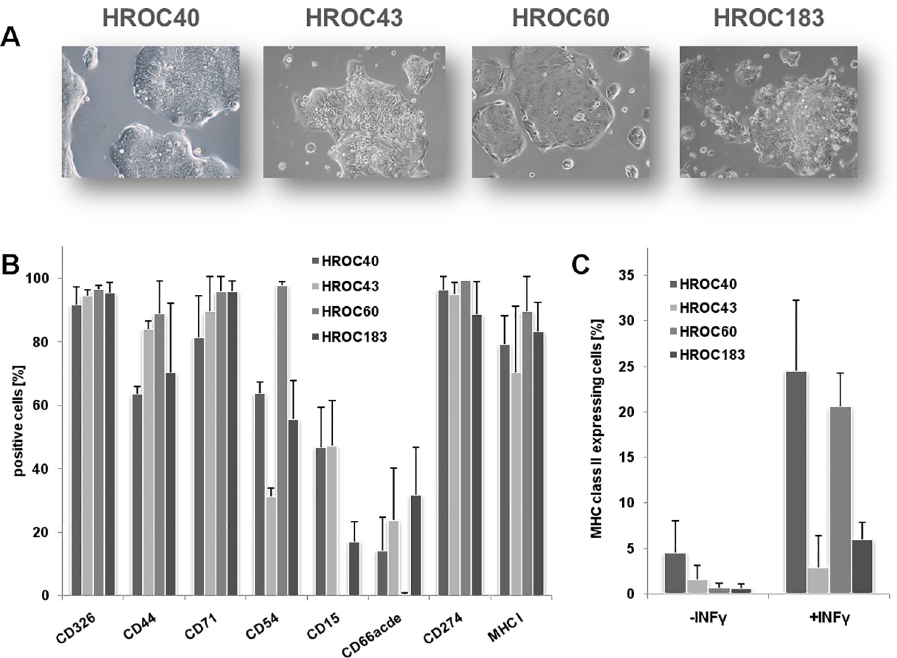
Fig 2. Morphology and phenotype of individual CIMP + cell lines. ( A ) Light microscopy of freshly established tumor cell lines (all Passage 15). Cell lines were directly established from patients ’ tumor material as described in material and methods. Original magnification ×100. ( B ) Phenotyping was conducted by flow cytometry using fluorochrome-labeled mAbs as given on the x-axis. ( C ) MHC class II expression as assessed by flow cytometry with and without IFN- γ (200 IU/mL for 48 hours) pre-treatment. Results are given as the mean % of positive cells + standard deviation of three independent